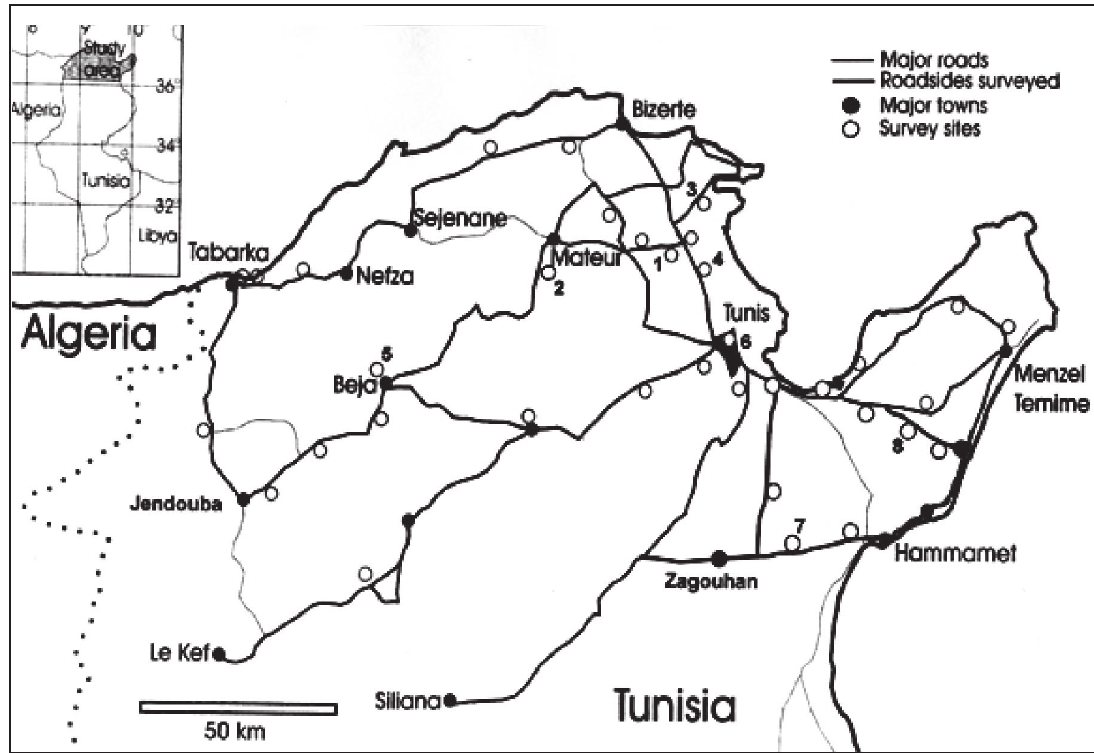
Fig. 1. location of wild radish ( Raphanus raphanistrum ) sites in northern tunisia during 2001–2002. Sites (crops) from which samples of diseased wild radish were collected were: (1) besbessia (bean and orchard of peach), (2) joumine (pastures), (3) utique (wheat), (4) Sabbelet ben ammar (chickpea), (5) Hammam Saïala (wheat and bean), (6) tunis (roadside), (7) Zagouwan (wheat), (8) beni Khalled (barley and orchard of